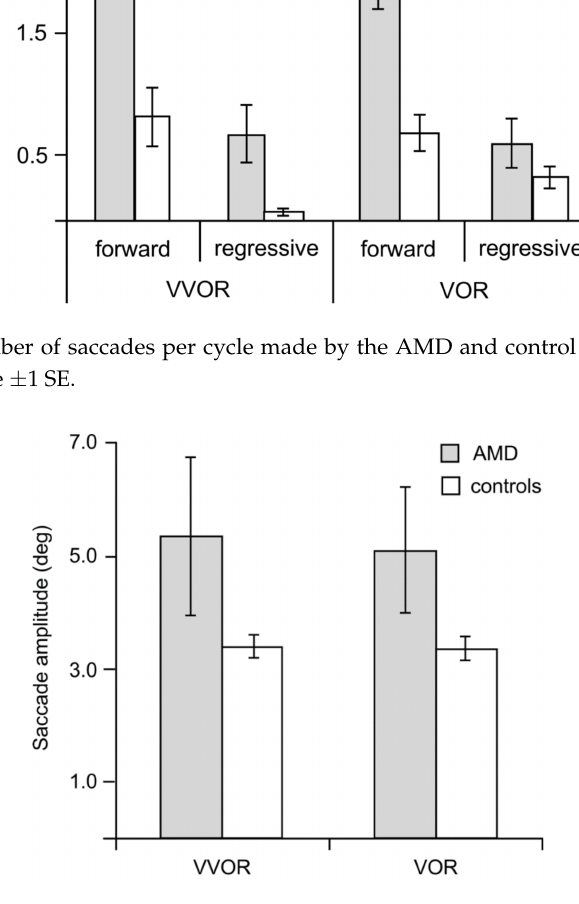
Figure 6. Mean amplitude (in deg) of the forward saccades made by the AMD (N AMD = 9) and control groups (N control = 15) during the 20 s of VOR testing. Error bars are ± 1